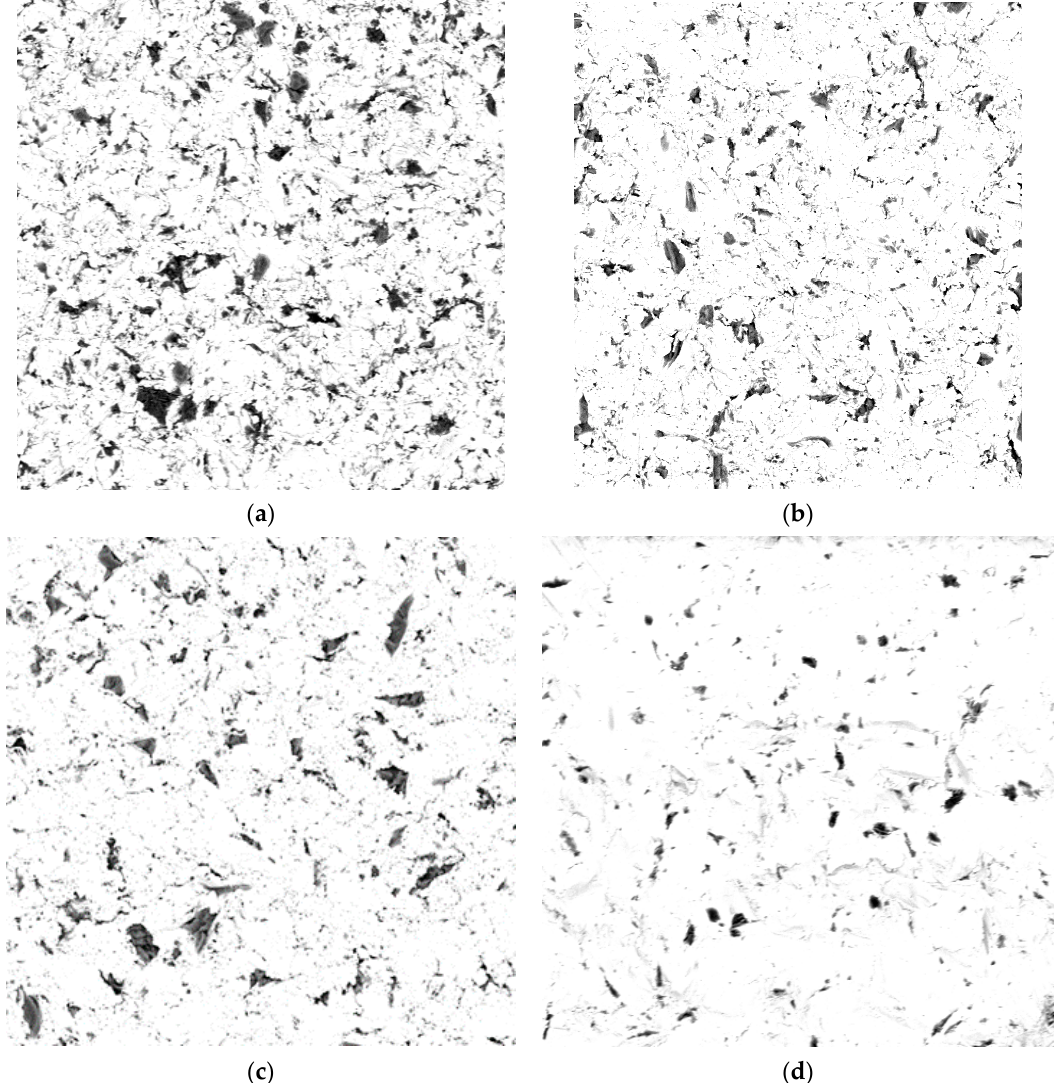
Figure 1. Images of Cr/Co alloy surface after abrasion with SiC 110 µm particles and under pressure of 0.2 MPa BSE obtained with (magnification 500×): ( a ) Ti alloy, ( b ) Ni/Cr alloy, ( c ) Cr/Co alloy, and ( d ) ZrO 2.